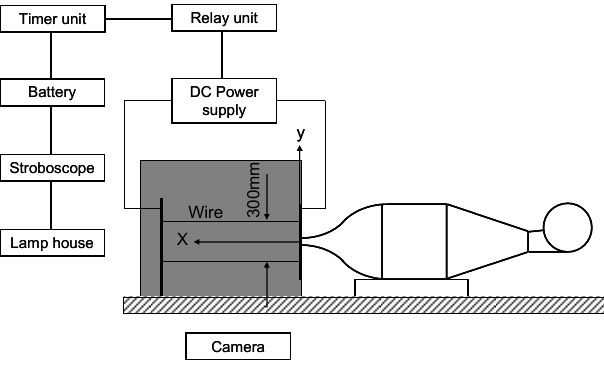
Fig. 9 Experimental setup of two dimensional jets.